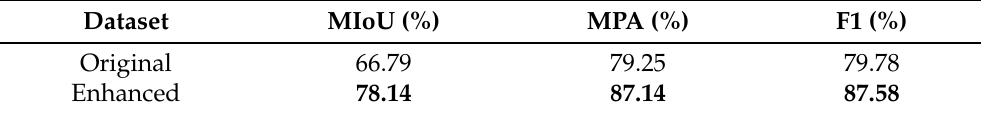
Table 5. Enhanced processing effect comparison.